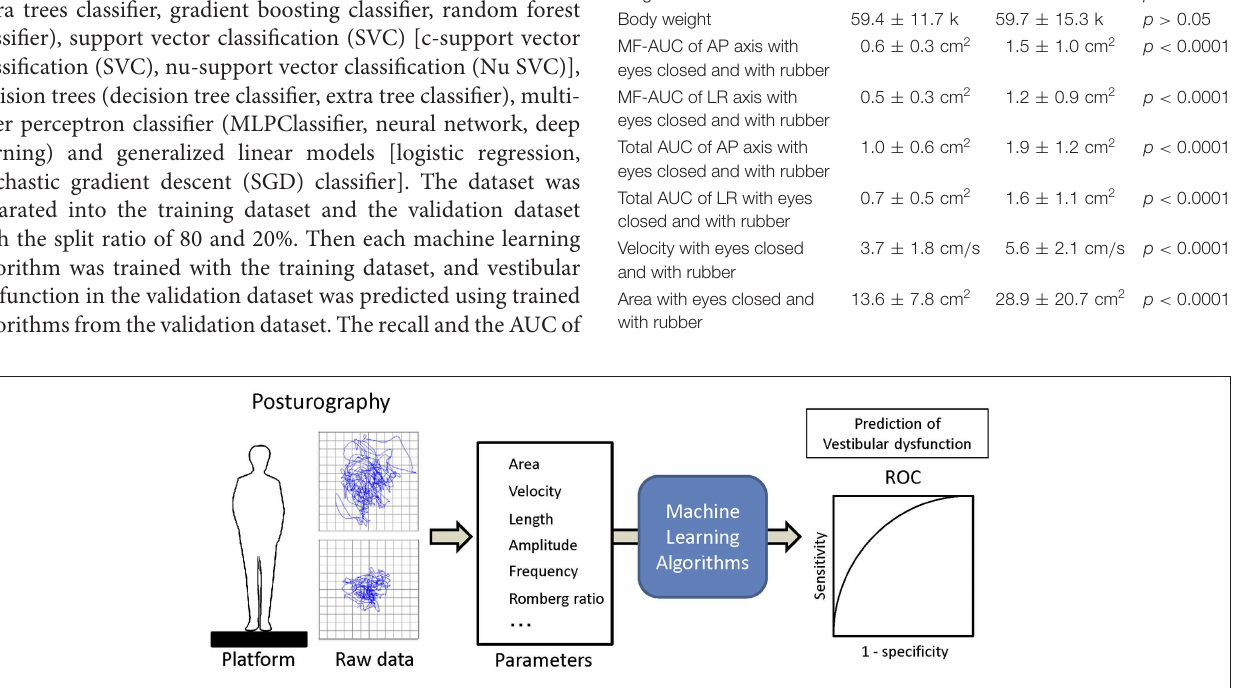
FIGURE 1 | Overview of the machine learning analysis from posturography data.